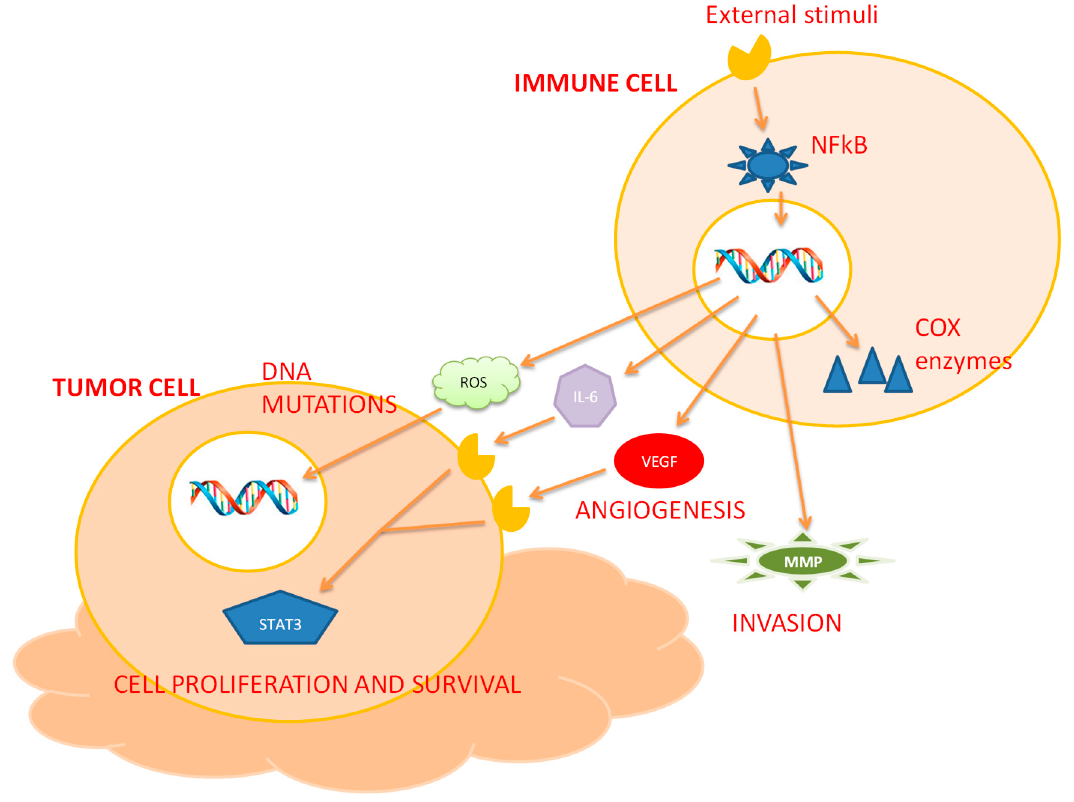
Figure 1. Inflammation and cancer. Various inflammatory and carcinogenic agents can activate the transcription factor NFkB. Once activated, it binds to specific DNA sequences in the nucleus and induces the production of pro-inflammatory cytokines and COX enzymes. Activated immune cells produce specific cytokines (IL-6, VEGF, etc.) and metalloproteinases (MMP-2 and MMP-9). IL-6 and growth factors can induce STAT3 activation by leading to cell proliferation and survival while metalloproteases degrade the membrane basement, promoting cell invasion. Moreover, macrophages secrete a great amount of reactive oxygen species (ROS) and mutagenic agents against microbial agents that induce a persistent tissue damage and cause DNA alterations by contributing to tumorigenesis.